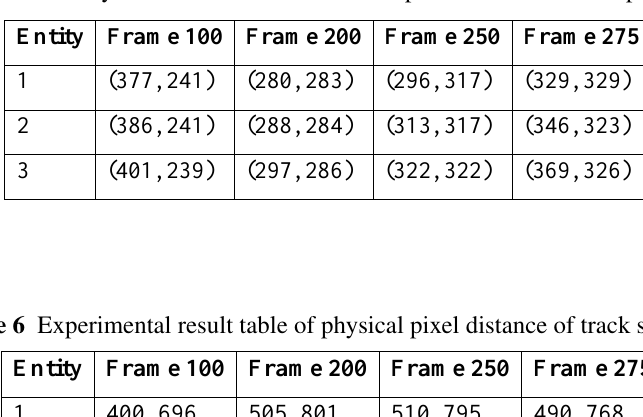
Table 5 Track system entity simulation two-dimensional position coordinate experiment result table